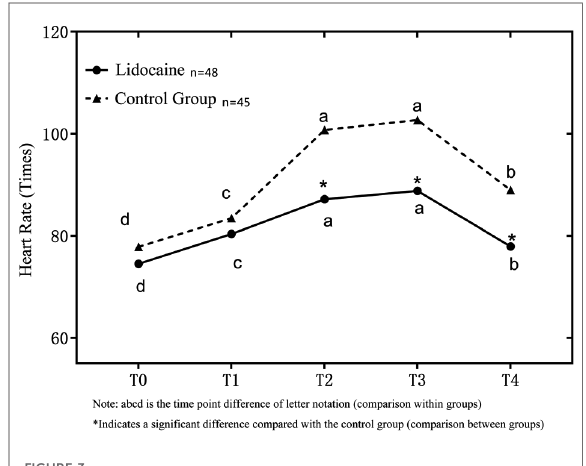
FIGURE 3 Comparison of heart rate (HR) between the two groups at different time